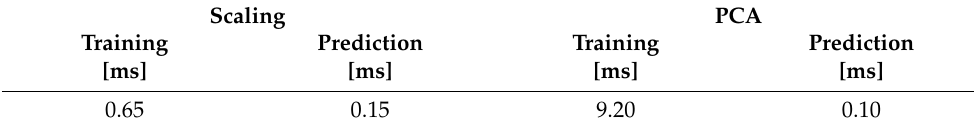
Table 5. Times of feature scaling and PCA